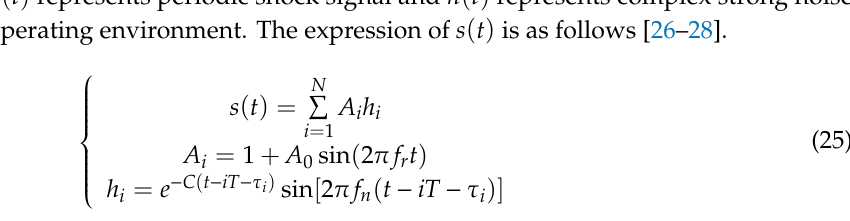
Table 1. Simulation parameters of rolling bearing fault model.